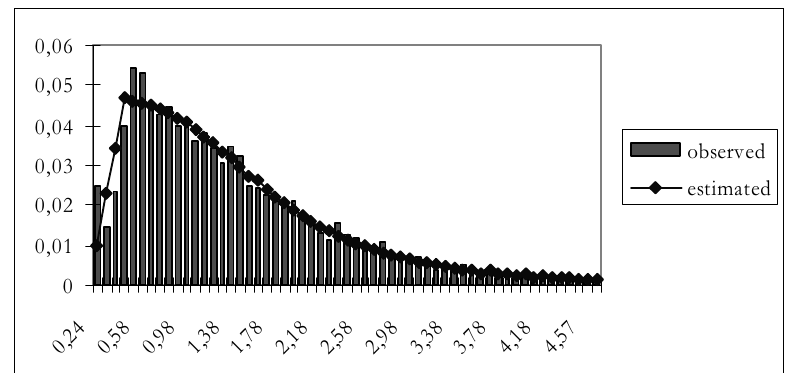
Figure 2 – Dagum model for human capital in Italy, 2004, observed data and estimated